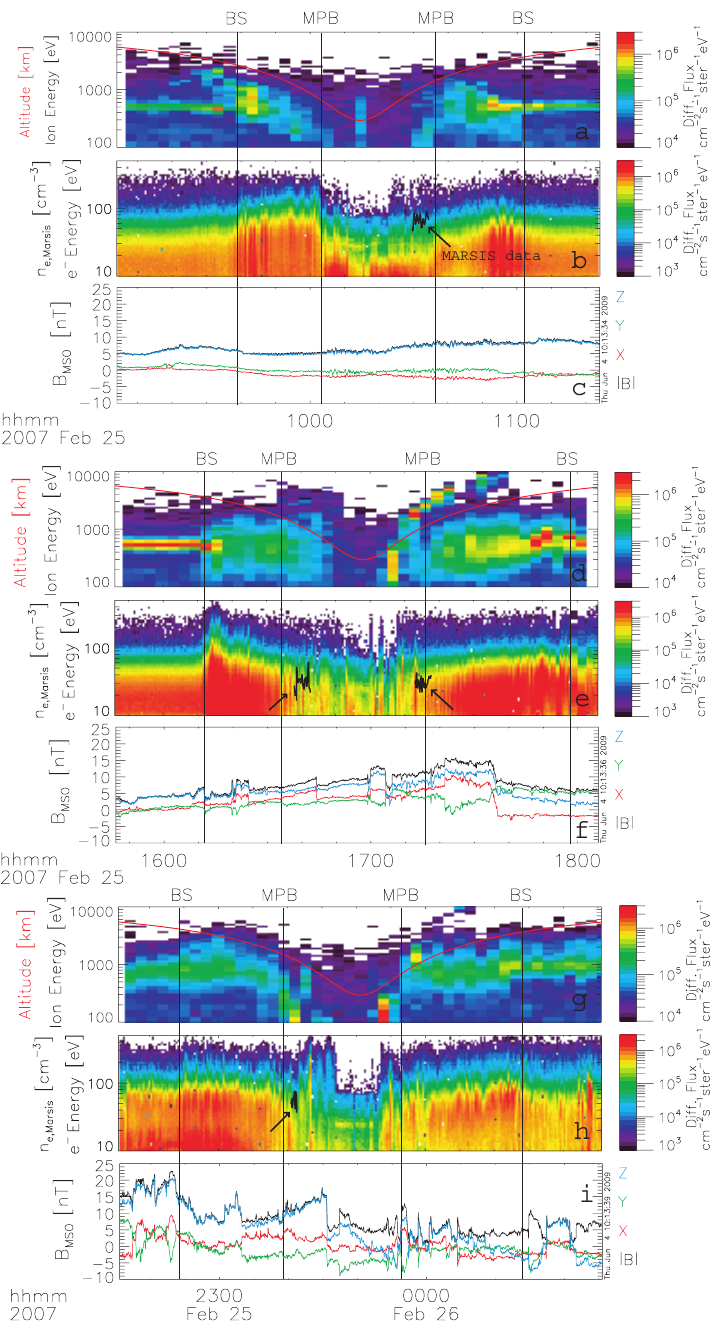
Fig. 5. Time series of MEX and Rosetta measurements. The panels show ( a , d and g ) MEX heavy planetary ion omni-directional spec- trograms, ( b , e and h ) MEX electron omni-directional spectrograms and ( c , f and i ) Rosetta magnetic field measurements during three consecutive MEX orbits. The downstream Rosetta measurements are time-shifted to the time frame of MEX. The heavy ion spectrograms contains a significant amount of ’ghost particles in the magnetosheath which are caused by a contamination inside the instrument by solar wind protons. The altitude of MEX is superposed on the ion spectrograms (red line, same scale as for the ion energy) and the local electron density from MARSIS is superposed on the electron spectrograms (short black line, same scale as for the electron density). The MARSIS data is only available during ∼ 5 min on each orbit an pointed out by black arrows. The time of the BS and MPB crossings by MEX are shown as vertical black